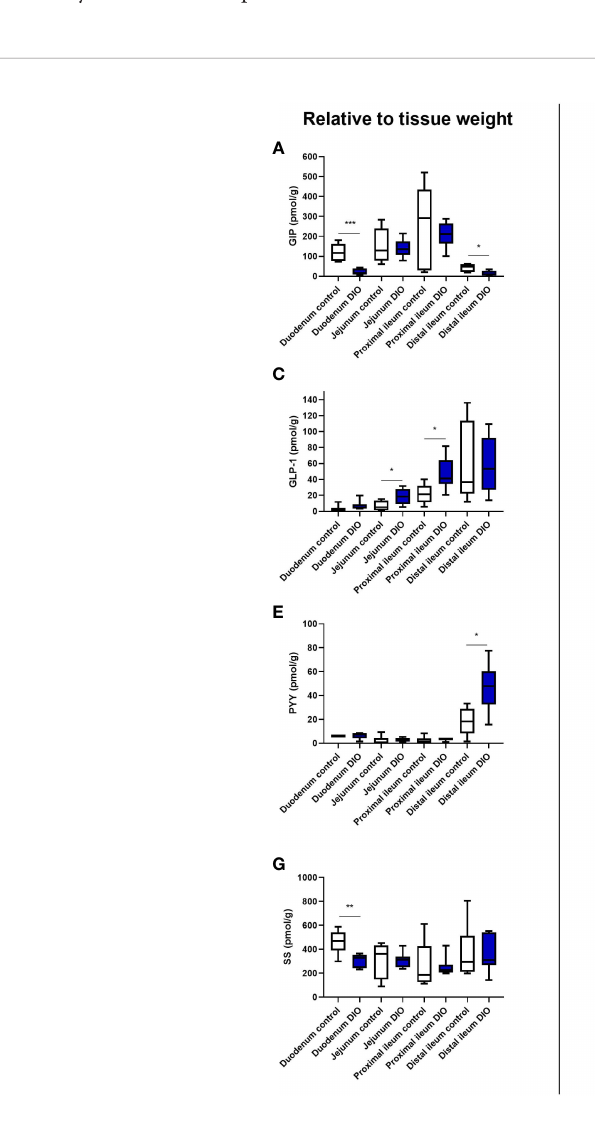
FIGURE 1 | Protein content of GIP, GLP-1, SS, and PYY in the small intestine from control mice and DIO mice. Hormone concentrations of total GIP (A, B) , total GLP-1 (C, D) , total PYY (E, F) , or total SS (G, H) were measured in different segments of the small intestine from tissue isolated from either control mice (white bars, n = 6) or DIO mice (blue bars, n = 7). The hormone concentration was either normalized to the wet weight of the tissue (A, C, E, G) or to total protein content (B, D, F, H) . Data are presented as mean ± SEM, and statistical signi fi cance was evaluated by a two-sided, unpaired Student ’ s t-test, *p < 0.05, **p < 0.01, ***p <